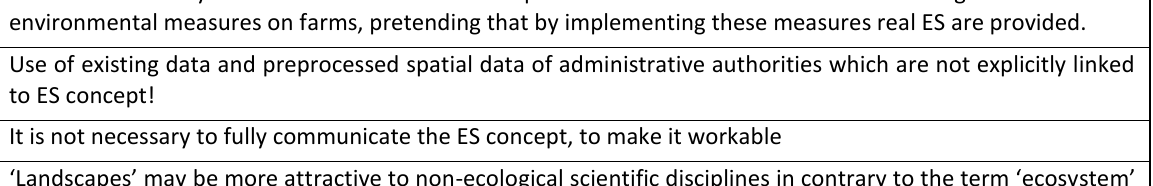
Table A2: Reasons for not (fully) explaining the ES concept to stakeholders (question 15.2) […] it seemed to be too complicated We communicated the concept but embedded it in broader discussions about uses and values of different land-cover and land-use options To be sure that stakeholders understand the questions Communication with stakeholders is more easy, if other terms are used We did not want to ask too much of the stakeholders and did not want to discourage them […] to keep the process simple and to make it easier for the stakeholder to understand [the aim] To help general understanding by not-technical stakeholders […] we know from other experiences that the concept is very hard to understand, even by environmental experts and that it raises discussion about the definition. The specific ES are generally well understood by interviewees, with a few exceptions.